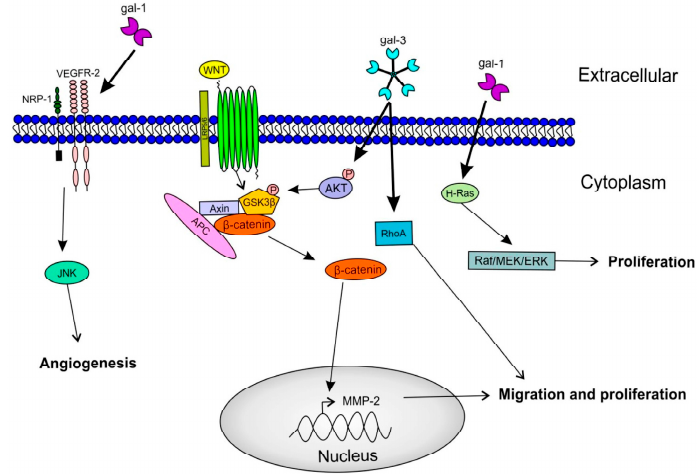
Figure 3. Involvement of galectins during carcinogenesis. Gal-1 interacts with Neuropilin-1/Vascular endothelial growth factor-2 (NPR-1/VEGFR-2) complex to promote endothelial cells migration through the c-Jun N-terminal kinase (JNK) pathway. Also, gal-1 interacts with H-Ras to stimulate cell proliferation by the stimulation of the Extracellular signal-regulated kinase (ERK) pathway. Gal-3 promotes cell proliferation and cell migration by the activation of β -catenin through the Phosphoinositide 3-kinase (PI3K)/Akt pathway, but also through Ras homolog family member A (RhoA) signaling. Glycogen synthase kinase 3 β (GSK3 β ); Adenomatous polyposis coli